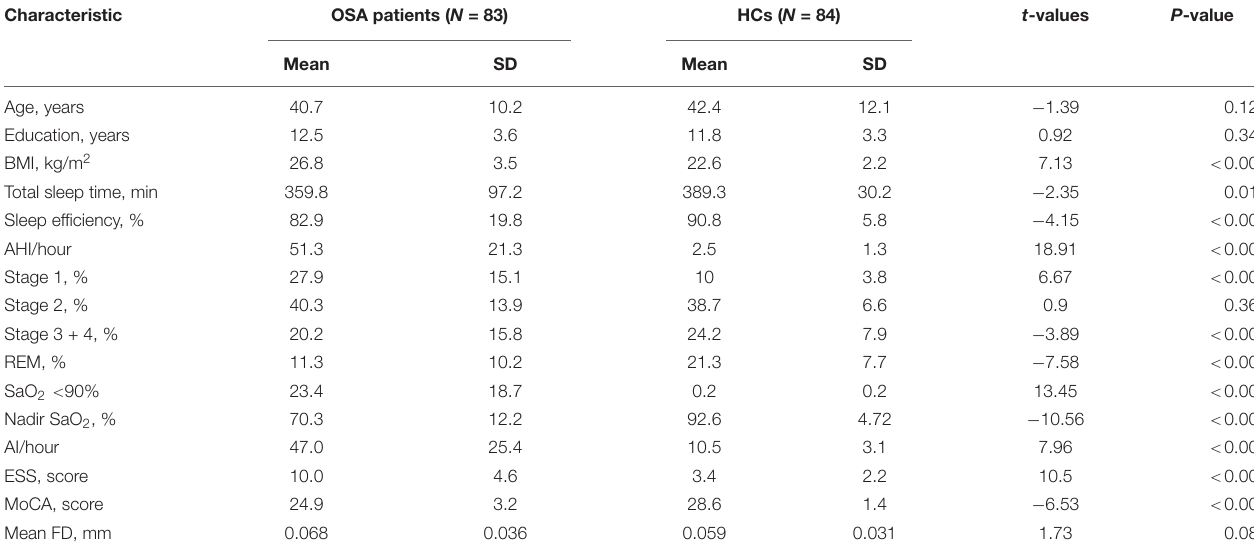
TABLE 1 | Demographic and clinical data between OSA patients and HCs. Characteristic OSA patients ( N = 83) HCs ( N = 84) t -values P